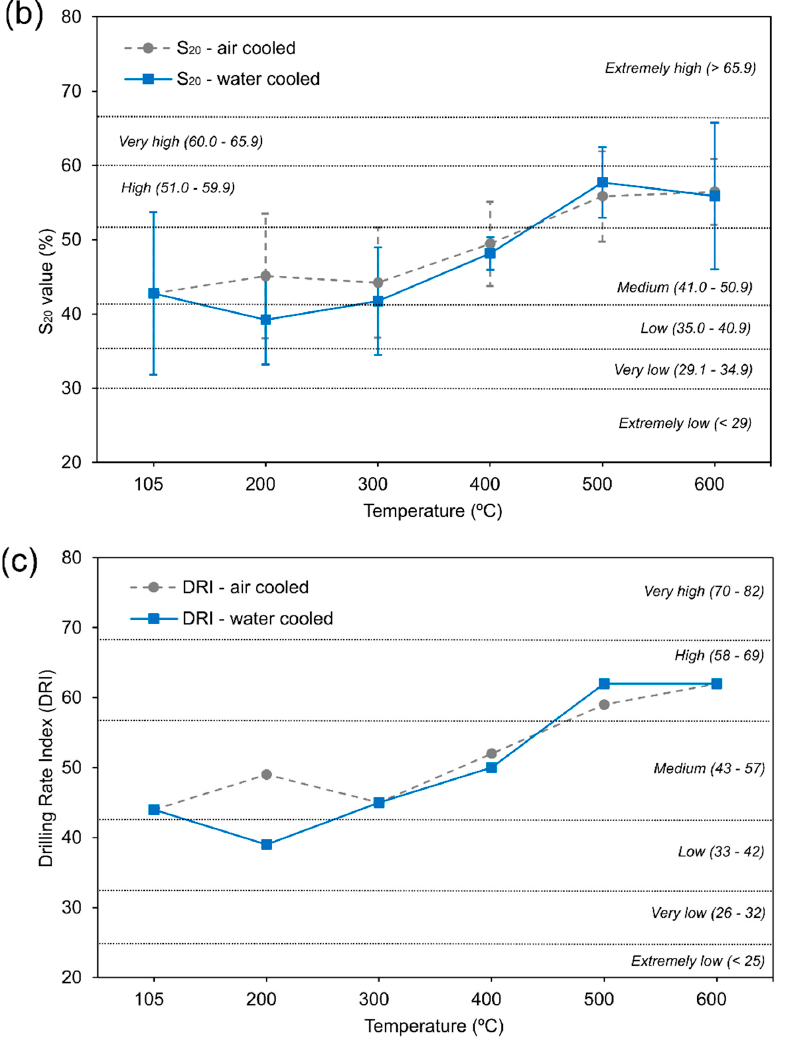
Figure 9. Variation with temperature of Siever’s J miniature drillability SJ ( a ), brittleness S 20 ( b ), and drilling rate index ( c ) for air- and water-cooled samples. Categories have been represented for Sj and S 20 according to Dahl et al. [49], and for DRI according to Bruland [41].